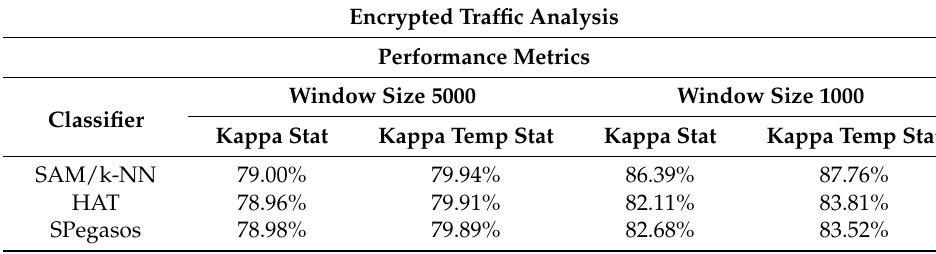
Table 9. Comparison between algorithms.